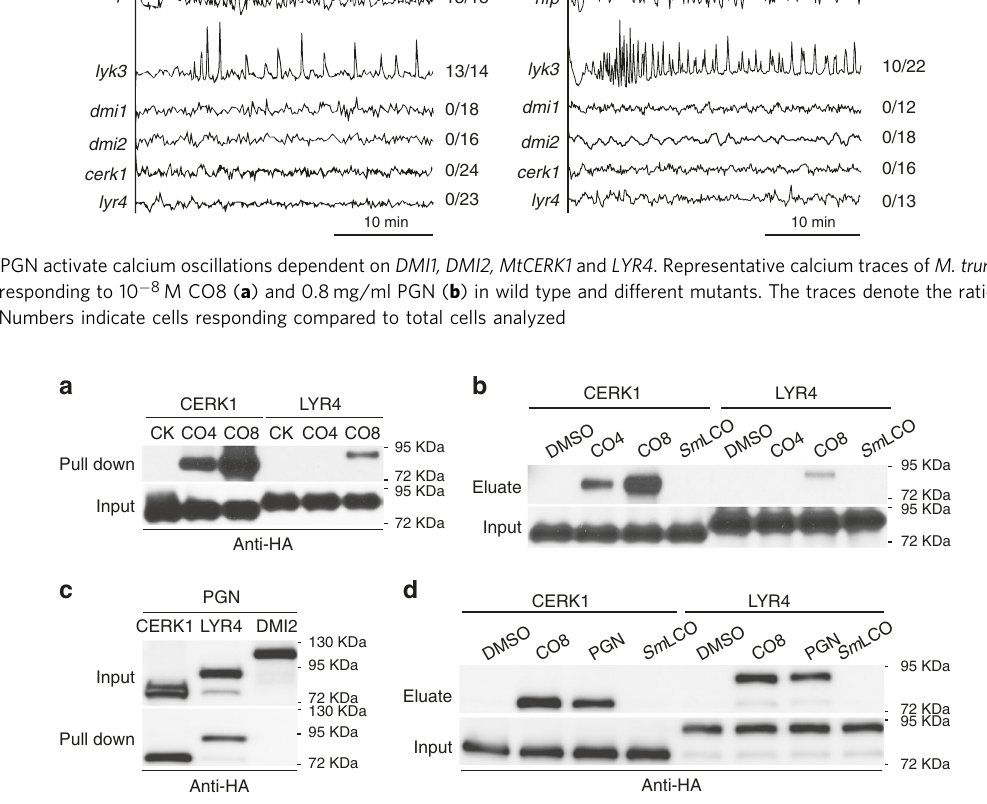
Fig. 3 LYR4 and Mt CERK1 bind to COs and PGN. a LYR4 and Mt CERK1 binding with streptavidin beads fused to either CO4 or CO8. CK: streptavidin beads alone. b Mt CERK1 binding with CO4 beads can be eluted by addition of CO4 and CO8. LYR4 binding with CO8 beads can be eluted with CO8, but not CO4. c LYR4 and Mt CERK1, but not DMI2, bind to insoluble PGN and d bound proteins can by eluted by CO8 and the soluble fraction of PGN, but not Sm LCO. The protein expression level of LYR4 and Mt CERK1 used in the binding assay is shown as